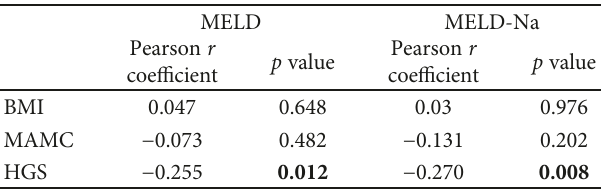
Table 4: Correlations between MELD and MELD-Na and BMI, MAMC, and